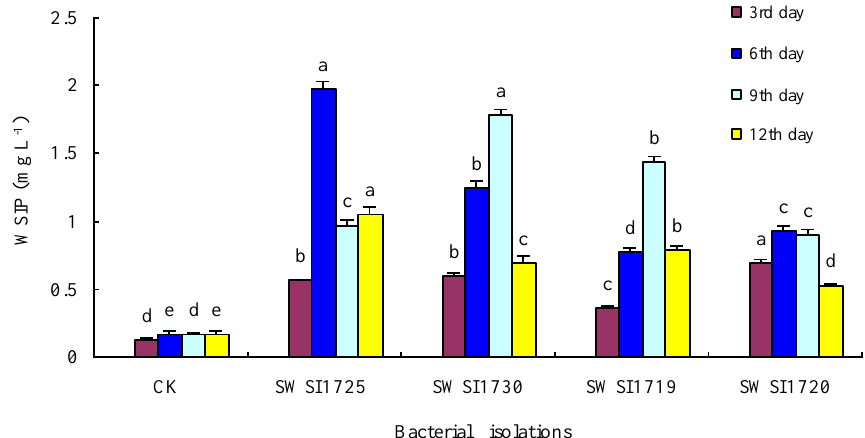
Figure 4. Comparative increases or decreases in WSIP by representative bacterial isolates in Sterile sediments on different incubation days in overlying water. Note: The strains of SWSI1725, SWSI1730, SWSI1719, and SWSI1720 indicate the treatments inoculated. Data are means ± S.E., with the same letters on the same day of incubation denoting insignificant differences among bacterial isolates.